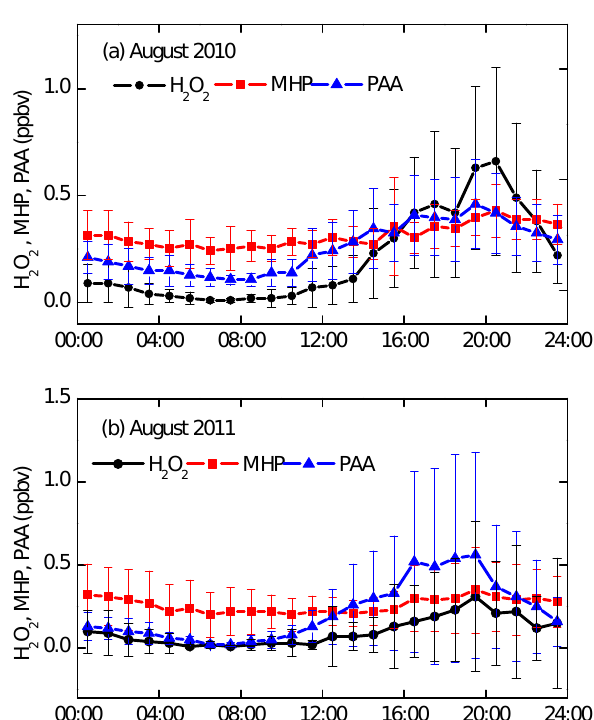
Fig. 2. Hourly-averaged diurnal cycles for peroxides in the summer of 2010 and